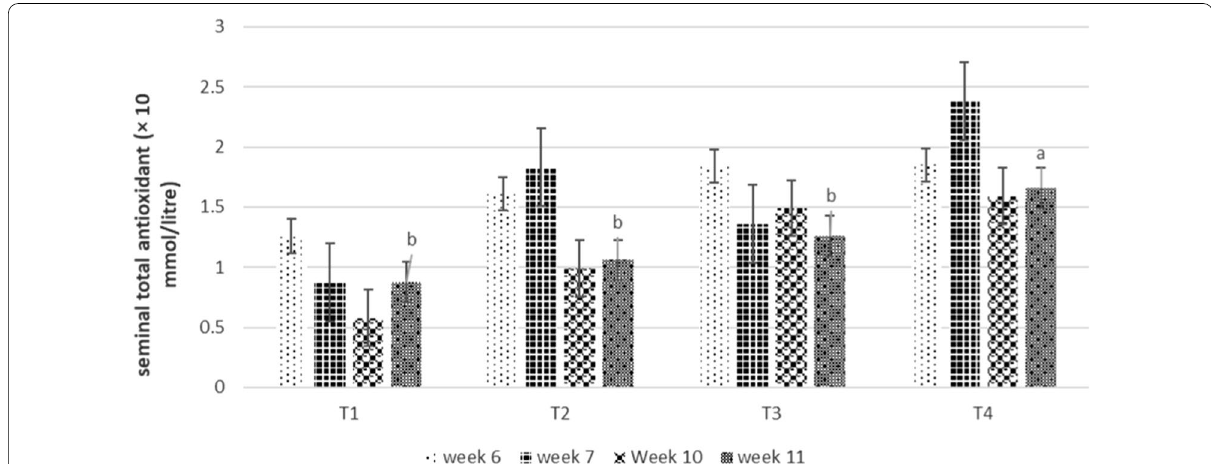
Fig. 6 Seminal total antioxidant activity of heat-stressed bucks administered ascorbic acid, sodium bicarbonate and its